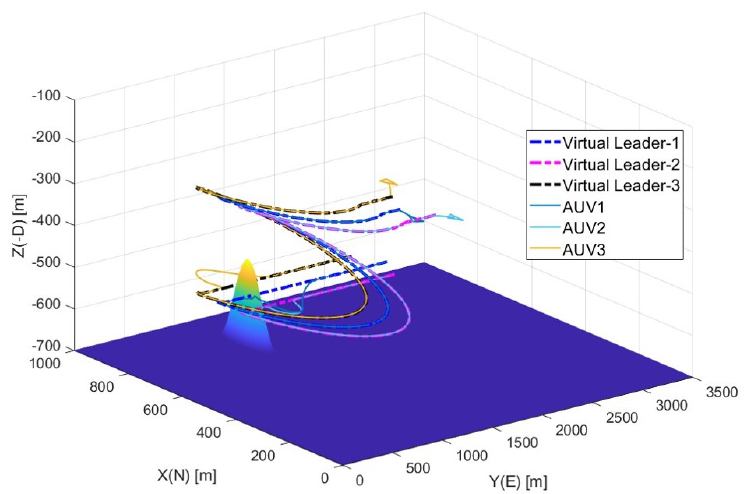
Figure 4. Virtual leaders trajectories and their trajectory with obstacle avoidance using the proposed formation scheme.